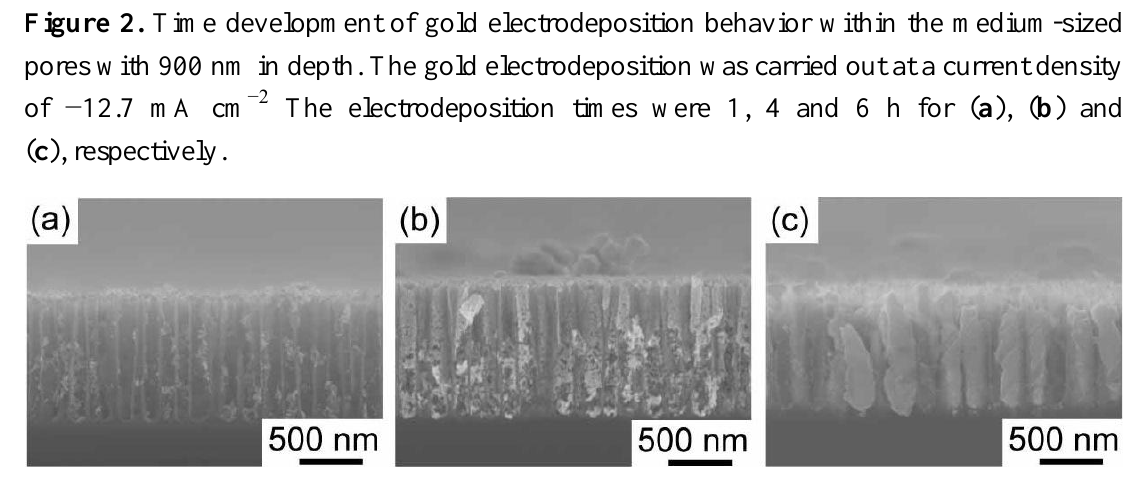
Figure 3. Gold-embedded porous silicon. The length of gold deposits is ~600 nm. The top and cross-sectional views are shown in ( a ) and ( b ),